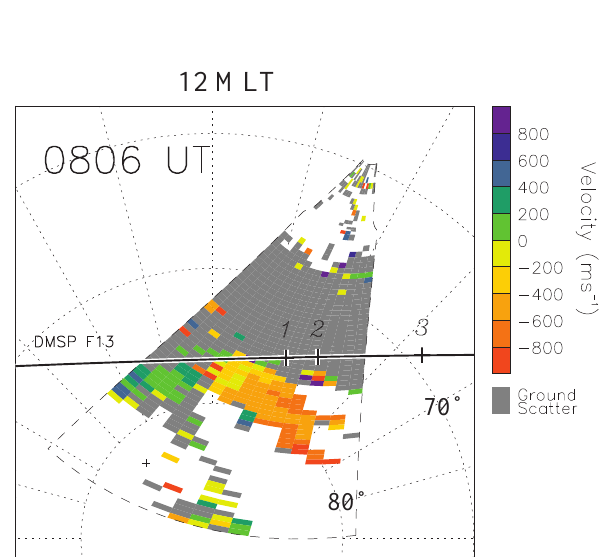
Fig. 5. DMSP measurements of the fluxes of precipitating electrons and ions, 16 September 1998, 08:05 to 08:08:30UT. The lines labelled 1, 2 and 3 show the position of the space- craft at 08:05:20, 08:06 and 08:08:20, respectively.